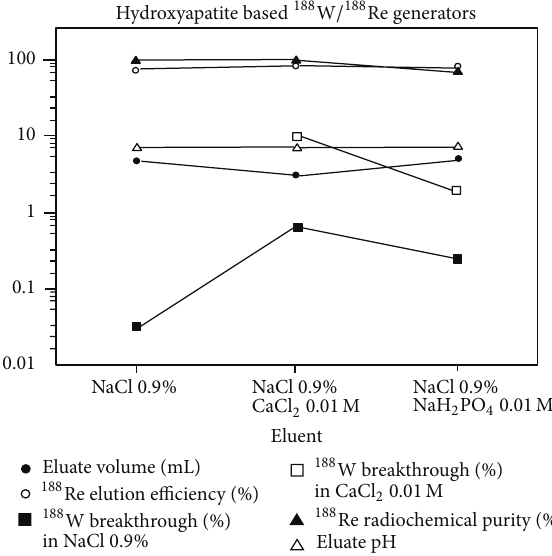
Figure 8: Performance of the hydroxyapatite based 188 W/ 188 Re generators as a function of the eluent (series C)